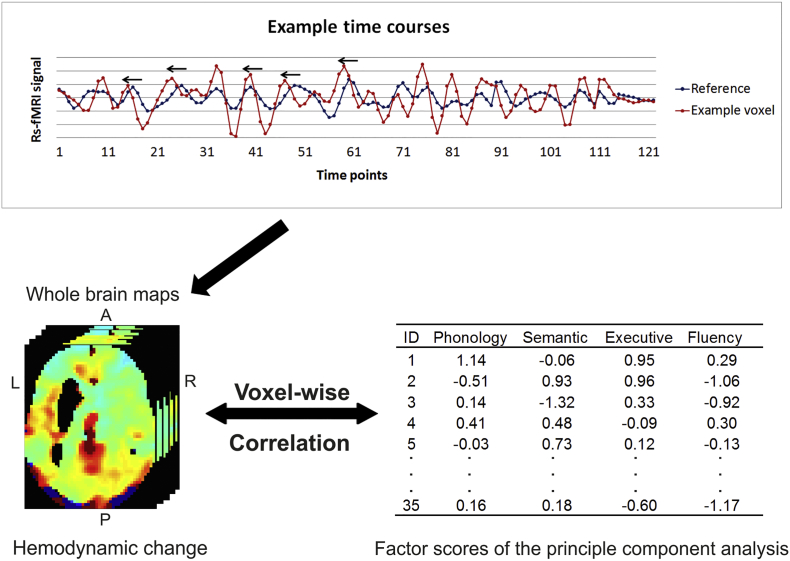
Main analysis. The top panel is an example time course of a voxel and the reference signal. The example voxel appears to be shifted to the left, leading before the reference signal. The bottom panel is the correlational analysis between voxel-wise homonymic changes and factor scores across patients who had intact tissue for each voxel.